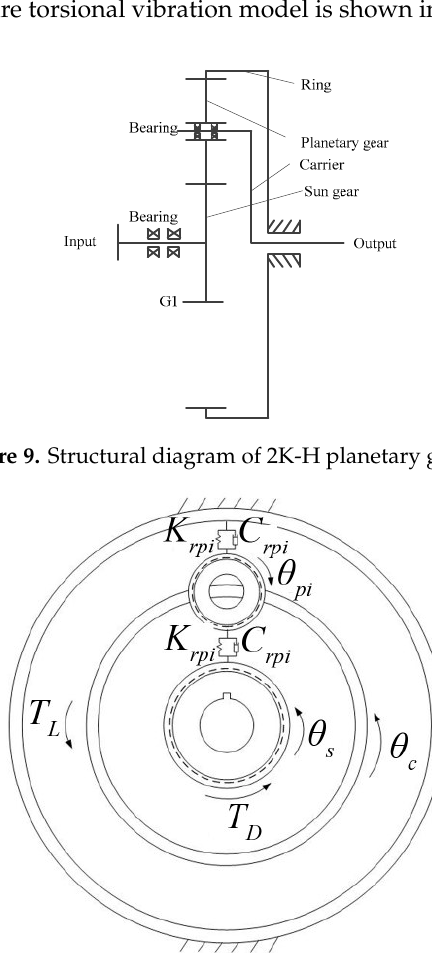
Figure 10. Pure torsional vibration model of the 2K-H planetary gear set.